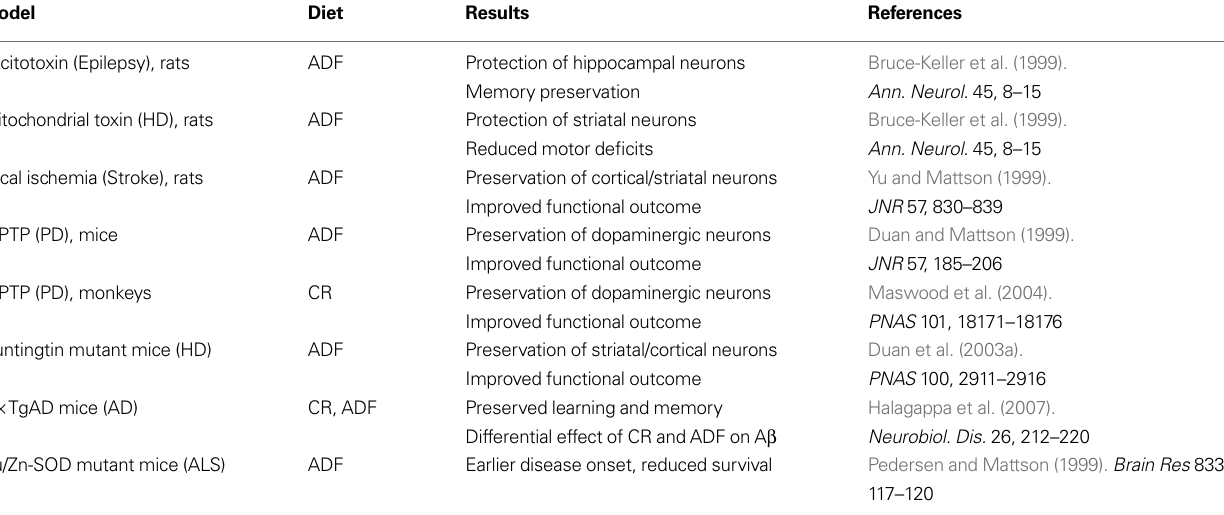
Table 1 | Infl uence of dietary energy restriction on neuronal vulnerability in animal models of acute CNS injury and chronic neurodegenerative